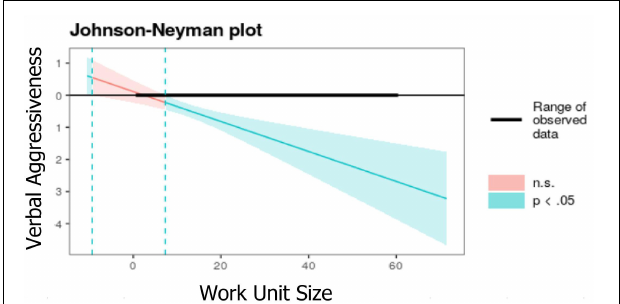
FIGURE 3 | The moderating effect of WUS on the relationship between verbal aggressiveness and LMX.